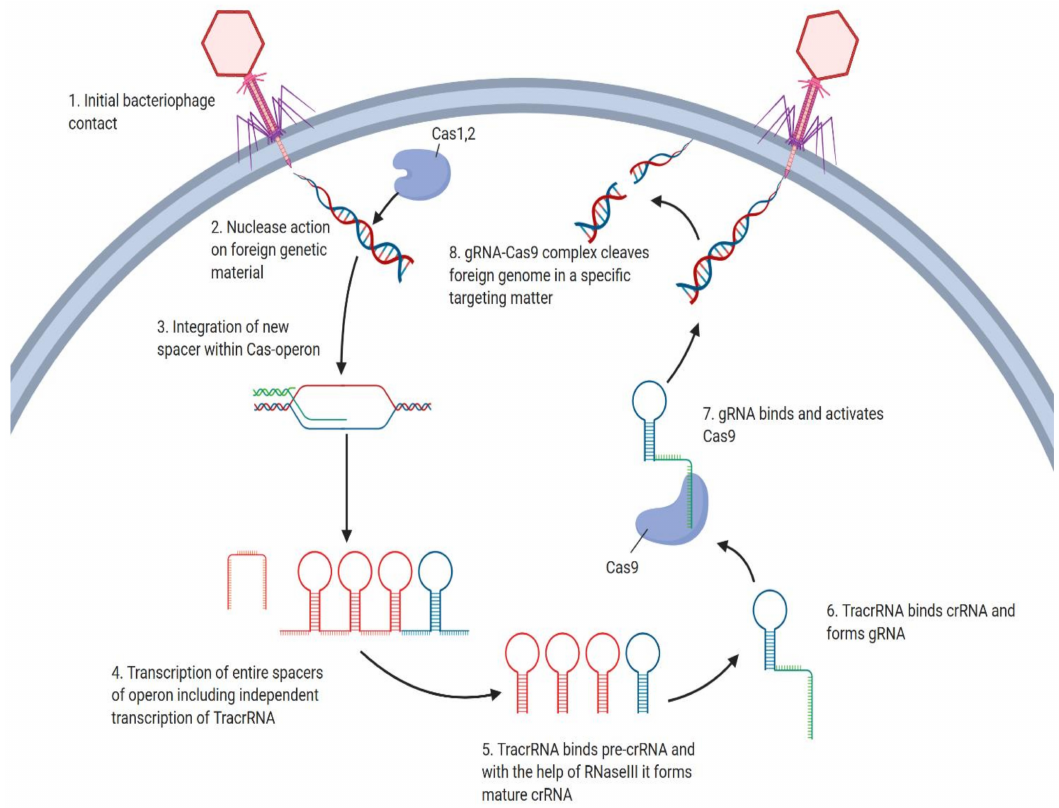
Figure 1. Once the invading genetic material from the bacteriophage enters the cell (1), CRISPR associated proteins 1 and 2 (Cas 1,2) will degrade the material (2), which will then be integrated as a spacer within the Cas-operon (3). Transcription of the entire spacer within the operon will take place, and TracrRNA will be transcribed independently (4). TracrRNA binds to pre-crRNA, and with the help of RNaseIII, cleavage will form individual and mature crRNA (5). The formation of gRNA occurs once tracrRNA binds to crRNA (6). gRNA binds Cas9 (7), redirecting it to the subsequent bacteriophage genetic insertion resulting in the destruction of foreign material (8). Terminologies: Cas9: CRISPR associated protein 9; gRNA: guide RNA (guides and activates insertion / deletion of Cas9 thus is used for activation and target specificity); tracrRNA: trans-activating CRISPR RNA (forms a complex with gRNA and acts as a homing device for directing Cas9 to invade foreign genomic material); crRNA: CRISPR RNA; PAM: Proto-spacer Adjacent Motif (a component of the virus or plasmid that plays an important role in target DNA selection and degradation); anHNH: nuclease system component of Cas9 that cleaves target DNA; RuvC-like: nuclease system component of Cas9 that cleaves the non-target DNA; RNAi: RNA interference (RNA molecule that inhibits gene expression / translation by neutralizing target